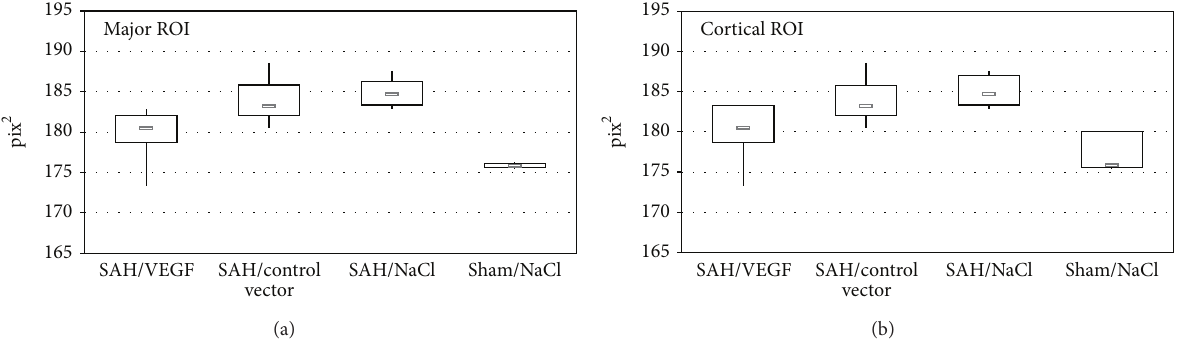
Figure 3: Minimum intense projection of cortical (without angiographic visible vessels) and major ROIs (with angiographic visible vessels): values of minimal intense projection are inversely correlated with the amount of perfused vessels. Displayed are the lowest, highest, and median pix 2 values, with upper (75%) and lower (25%)